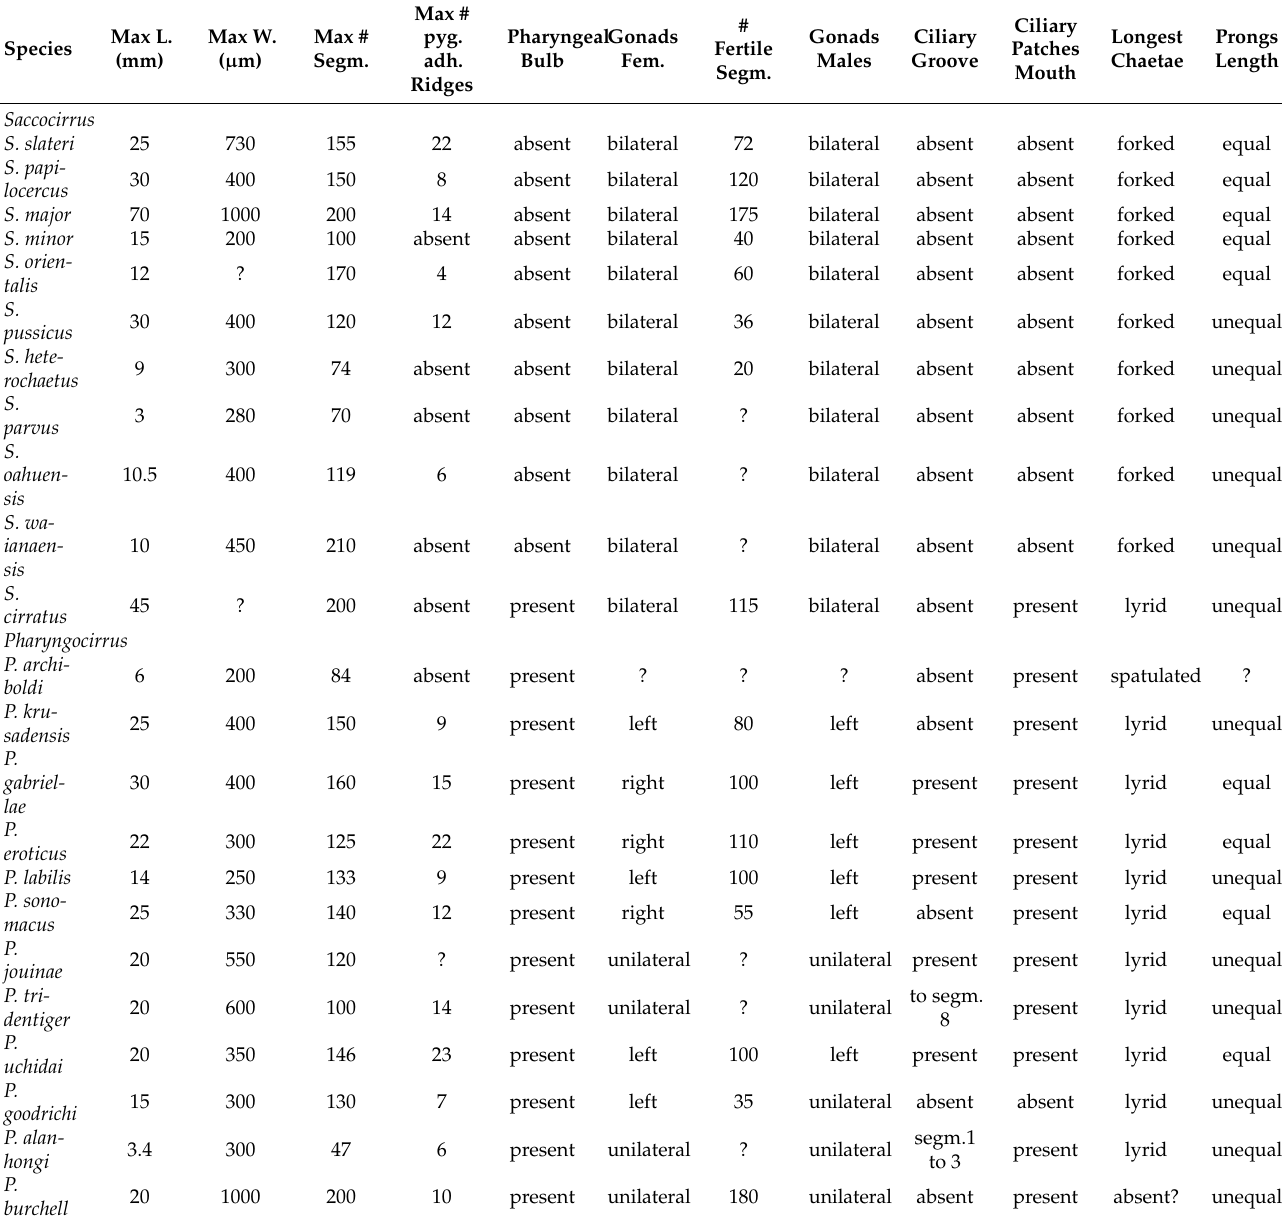
Table 4. Meristic and morphometric characters of described species of Saccocirrus and Pharyngocirrus . Abbreviations: L, length; W, width; Max, maximum; #, number; pyg. adh., pygidial adhesive; Fem, Female; segm., segment; ?, unknown.